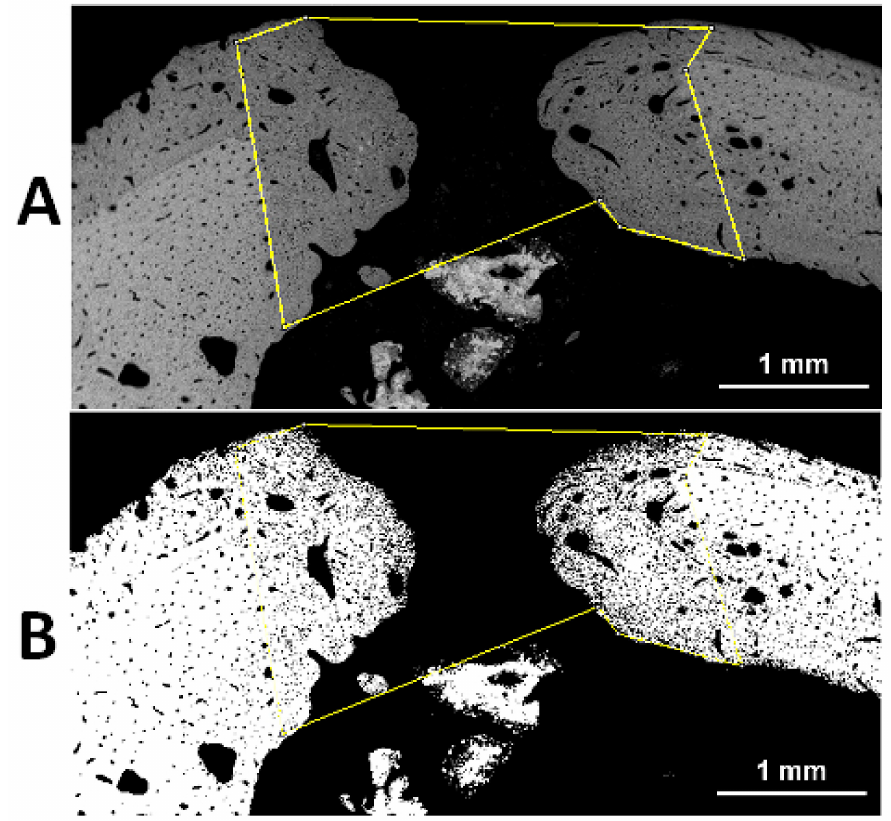
Figure 6. Representative backscattered SEM images of a osteotomy gap of a BGSr sample (see Figure 4A). Bone regeneration was evaluated by measuring, on digitalized pictures, the amount of newly formed bone present inside the gap expressed as BV/TV%. The area of bone present inside the osteotomy (BV) and the total area of the osteotomy (TV) were measured using the Image-J ‘polygon tool’, in order to calculate the BV/TV% value. The yellow polygon outlined the newly formed bone in the osteotomic gap (darker in A ). The adjusted black & white threshold ( B ) of the Image-J software allows digital measurement of BV/TV%